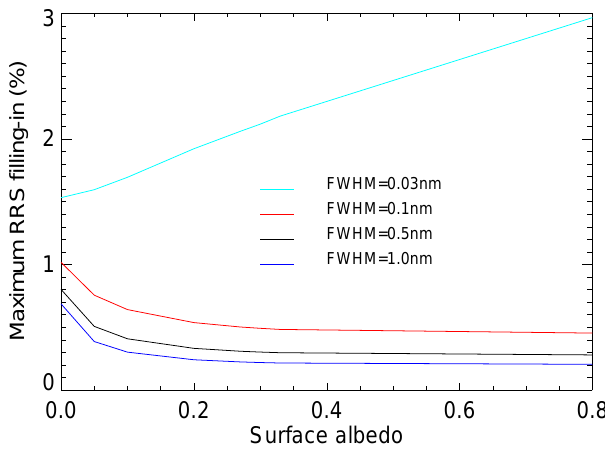
Fig. 13. Maximum percentage filling-in within 760–762 nm due to RRS as a function of surface albedo for SZA = 45 ◦ at nadir.